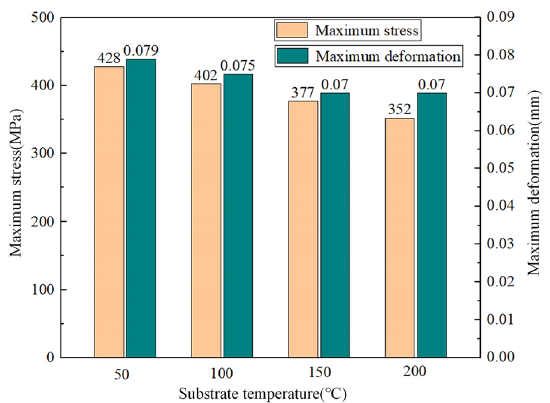
Figure 16 Simulation results of SLM forming M2 high-speed steel at different substrate temperatures